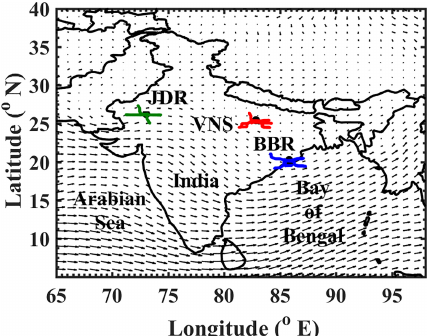
Figure 1. Geographical location of the aircraft campaign stations (solid circle) in the Indo-Gangetic Plain superimposed on the mean wind field at 850hPa during the campaign period. JDR, VNS and BBR stand for Jodhpur, Varanasi and Bhubaneswar. Daily flight tracks are superimposed on the stations JDR (green), VNS (red) and BBR (blue) from left to right. Each measurement track has a horizontal span of ∼ 150km from the base station.